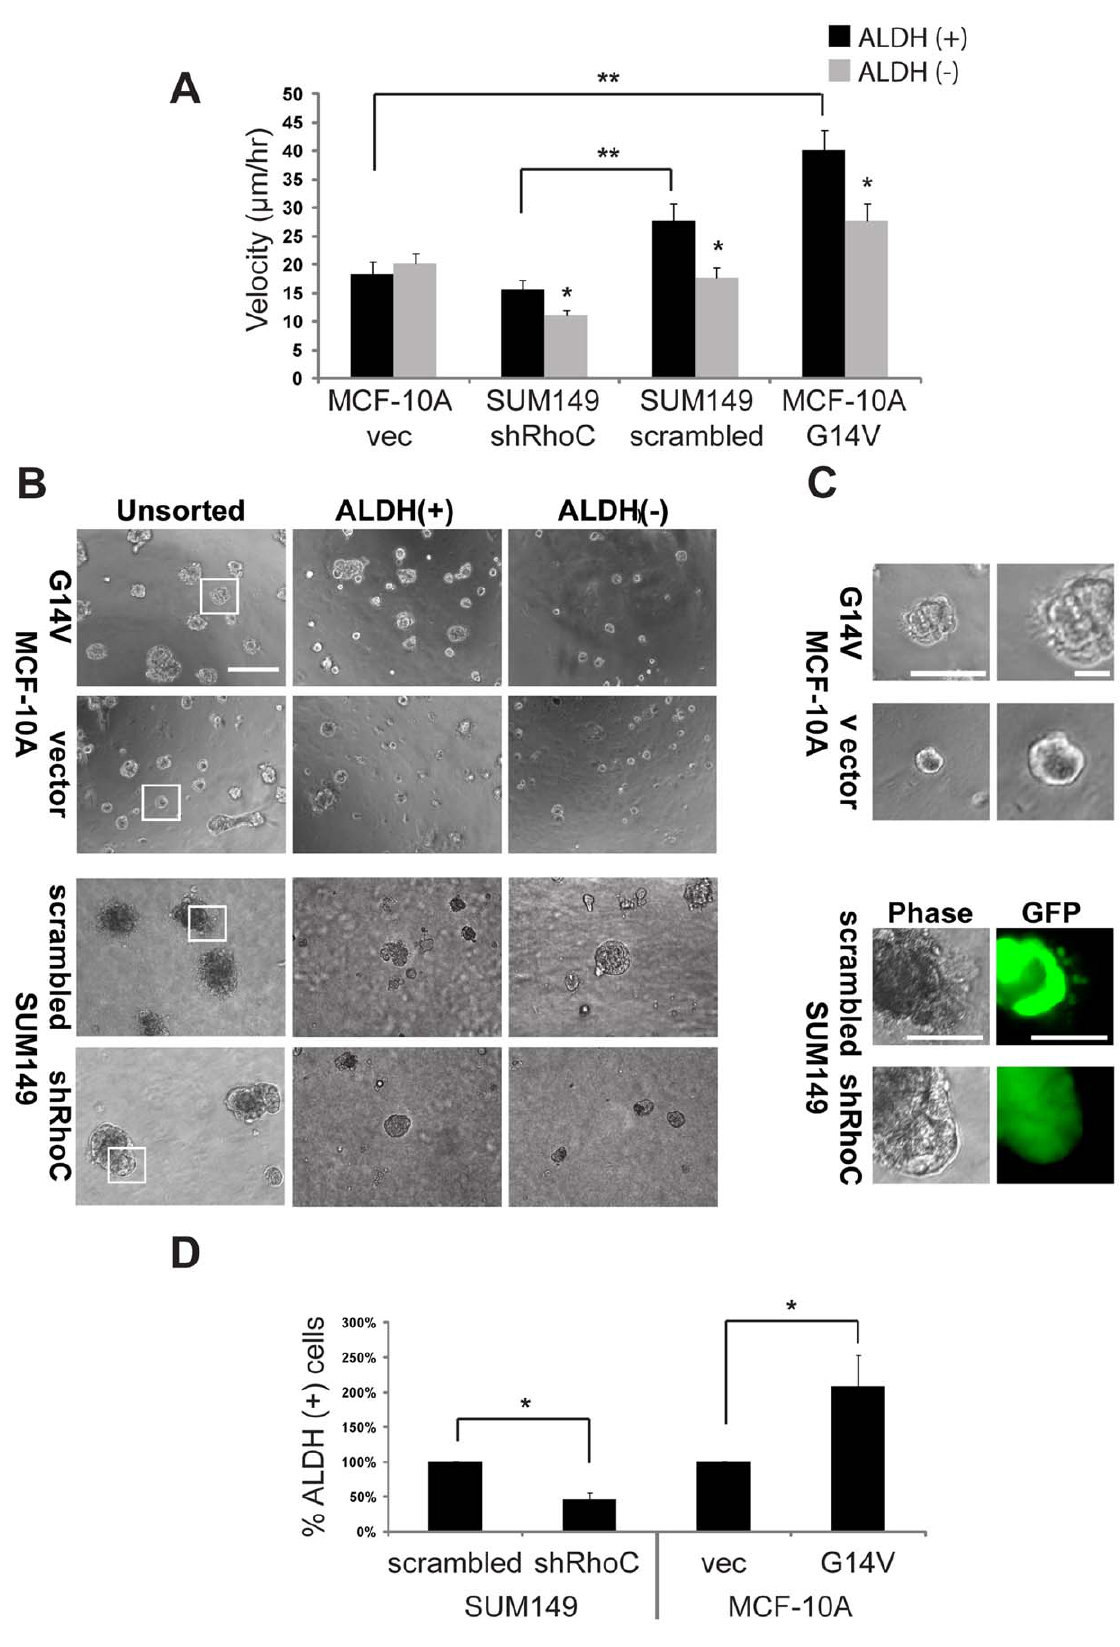
Figure 2. RhoC dictates the behavior and abundance of SUM149 and MCF-10A BCSCs. ( A ) RhoC expression determines cell speed, even within the ALDH ( + ) population. Comparing the ALDH ( + ) populations of each cell line, modulating RhoC expression causes corresponding changes in